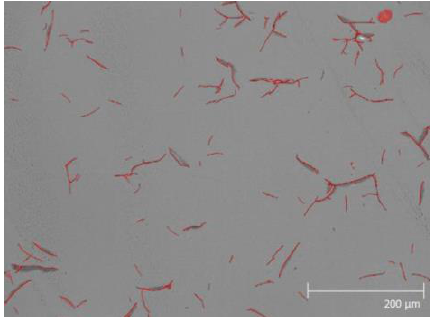
Fig. 2. SSD evaluation (marked red) with digital